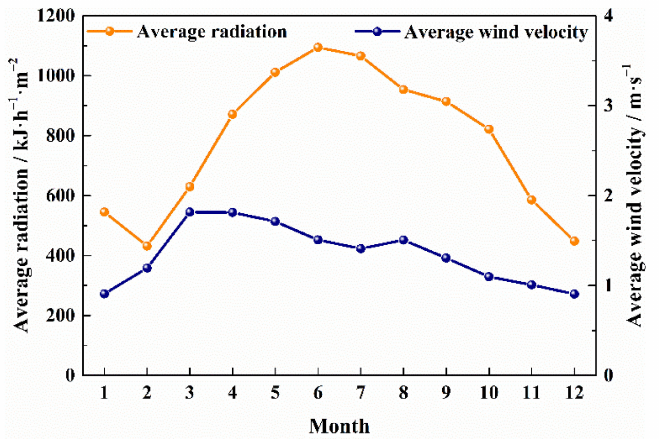
Figure 12. Monthly average radiation and wind velocity in Andir.